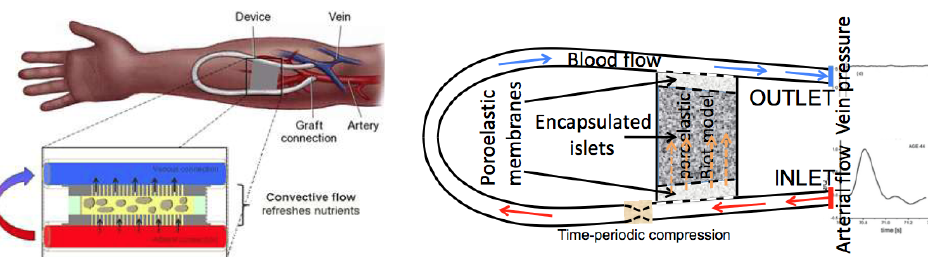
Figure 2. ( Left ): An illustration of the implantable intravascular bioartificial pancreas device in the arm of a T1D patient (from [5]). ( Right ): A sketch showing the graft and the encapsulation chamber consisting of two poroelastic membranes and the islet chamber in the middle. The figure also includes our suggestion for the placement of a time-periodic compression device downstream from the chamber, to increase convective flow into the chamber and flush out albumin deposits near the membrane observed in steady flow.